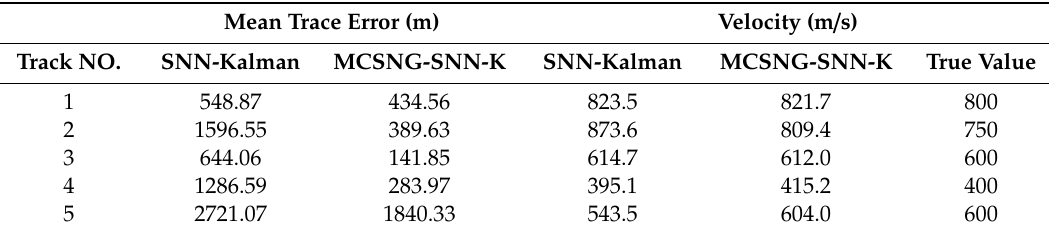
Table 5. The comparison of five targets tracing results between SNN-Kalman and MCSNG-SNN-K. Mean Trace Error (m)